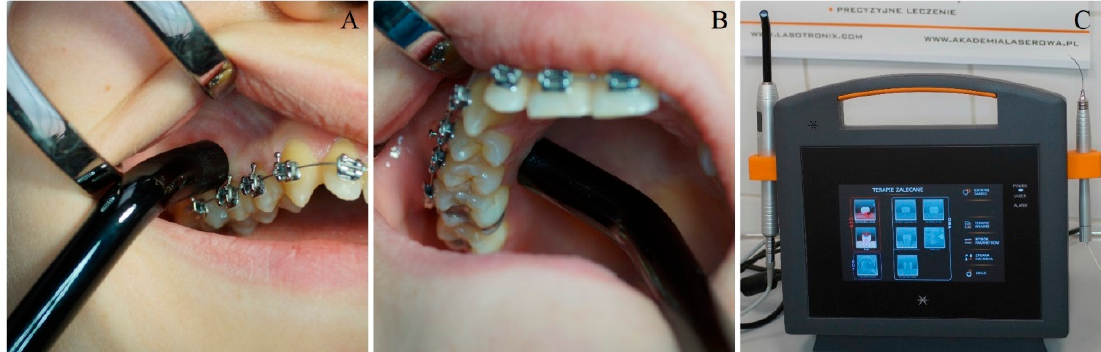
Figure 3. PBM with 635-nm diode laser on ( A ) a buccal and ( B ) a palatal side of the alveolus/implant. ( C ) Diode laser SmartM (Lasotronix, Poland) used in the study.